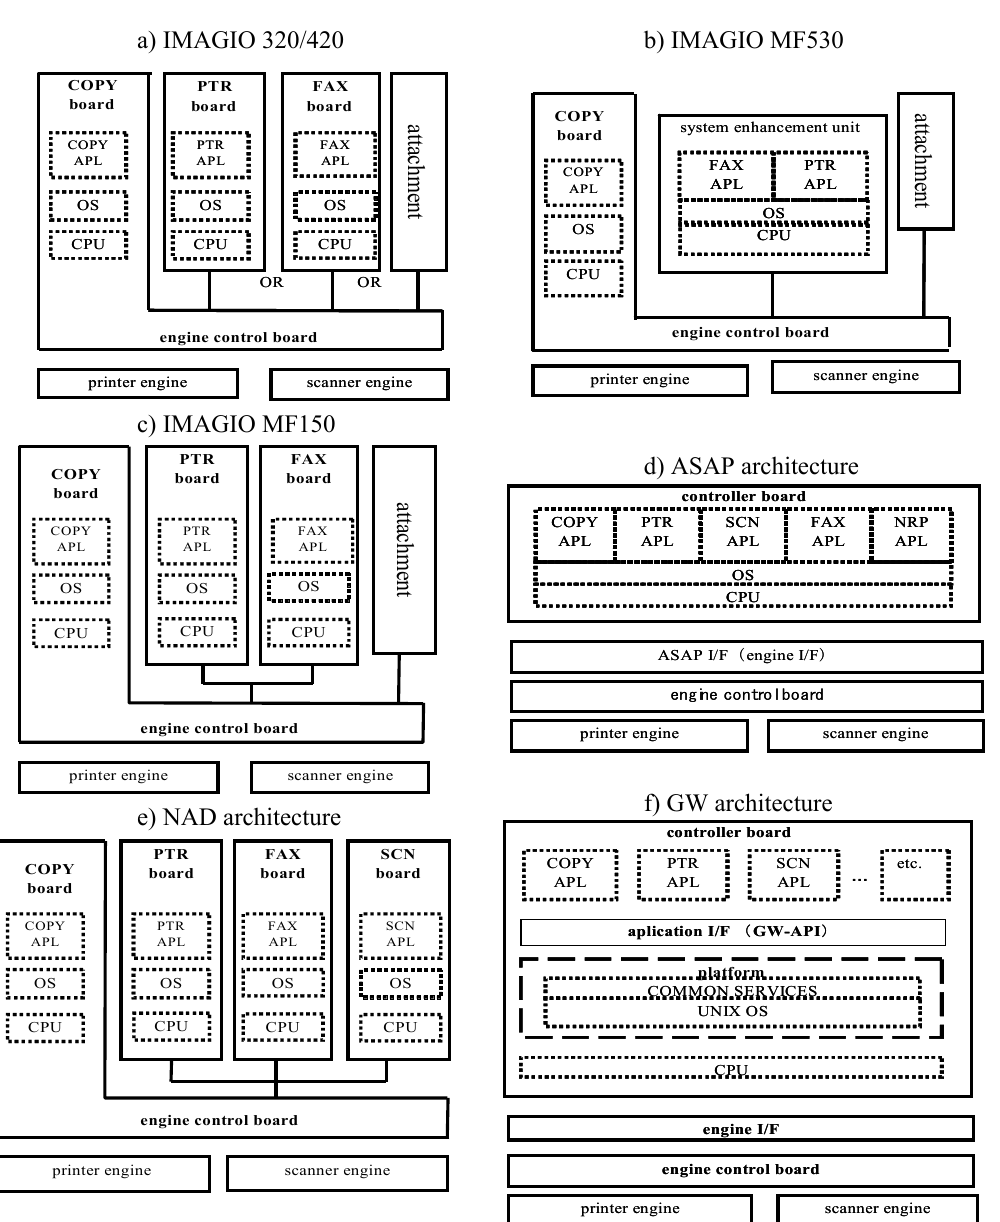
Figure 3. Transition of firmware architecture of digital MFP in